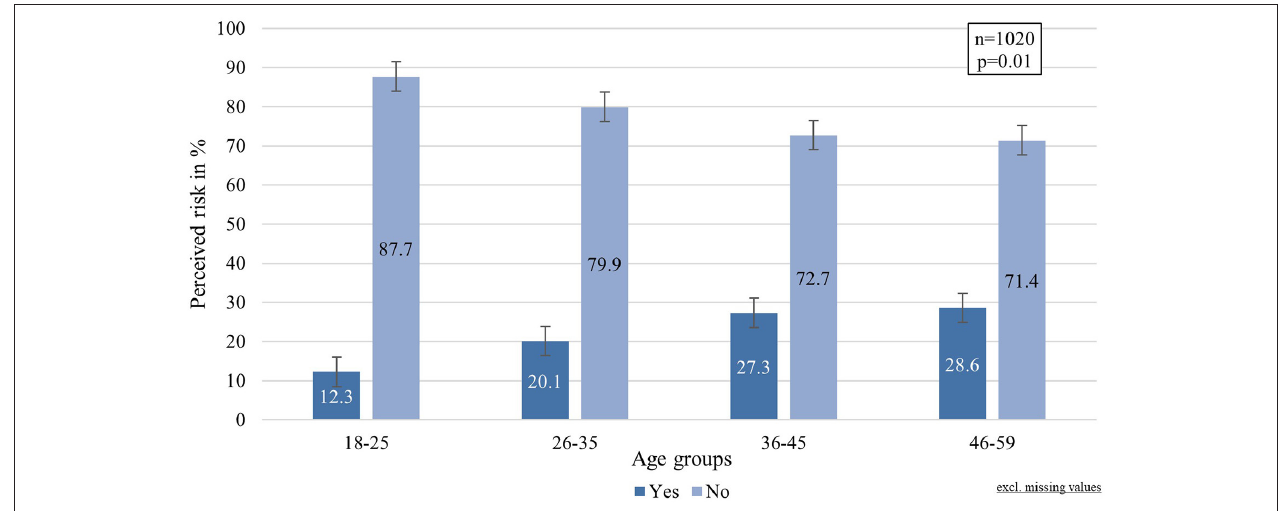
FIGURE 1 | Perceived risk of acquiring SARS-CoV-2 infection by age groups.